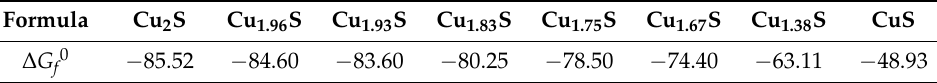
Table 2. Selected standard free energy of formation of Cu 1 + x S at 25 °C (kJ/mol) [1].